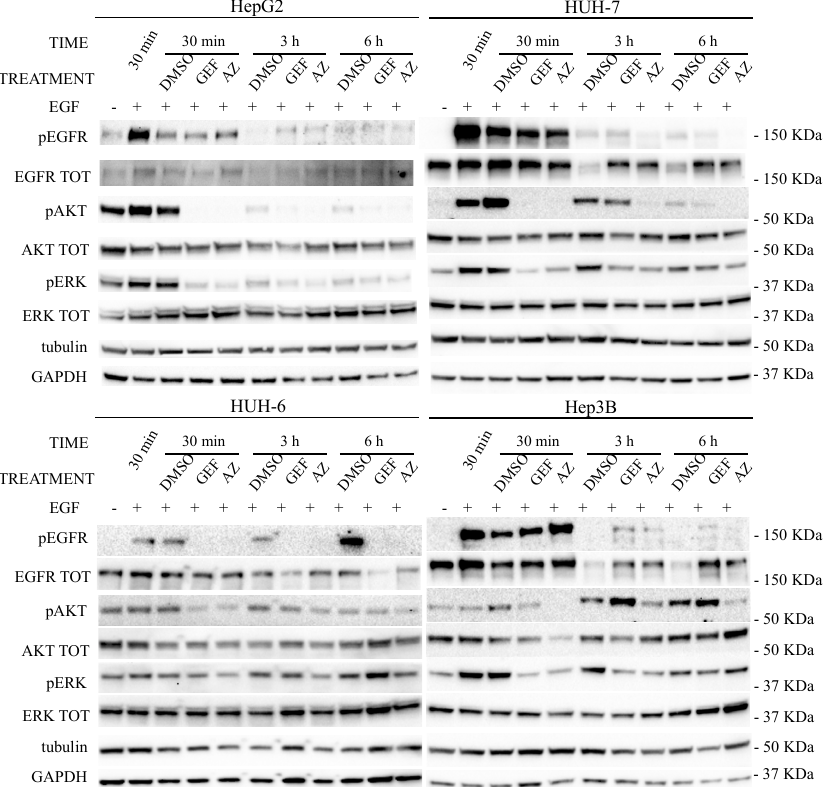
Figure 3. Western blot panels of HepG2, HUH-7, HUH-6, and Hep3B starved cell lines stimulated with 100 ng/mL of EGF for 30 min before and during treatment with GEF or AZ IC50 (as indicated in Table 1) (DMSO as control). Treatments were performed for 30 min, 3 h and 6 h. As expected, following EGFR signaling switch-off by GEF or AZ, the proliferation of all the cell lines analyzed was negatively affected by both drugs (Figure 4).